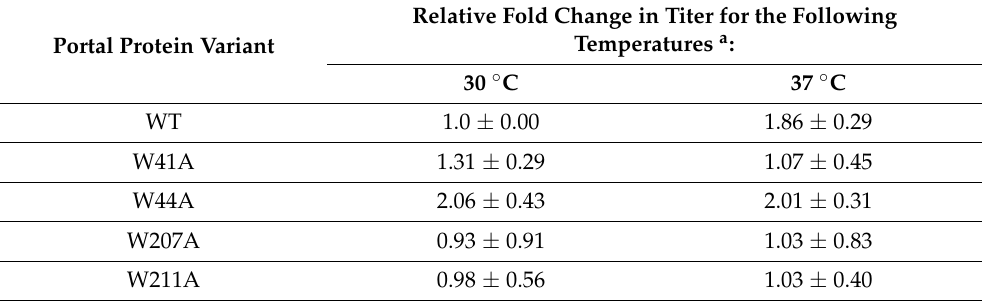
Table 3. Test of dominance of W to A portal protein variants on WT portal protein from phage. Relative Fold Change in Titer for the Following Temperatures a Portal Protein Variant